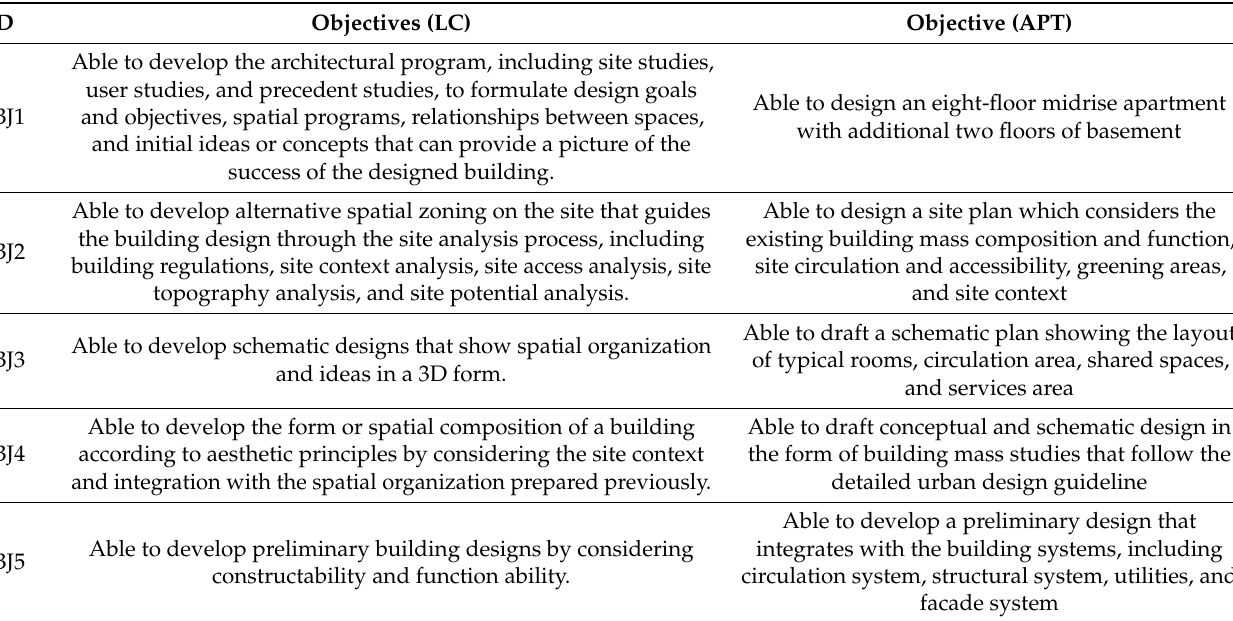
Figure 3. Site aerial view ( a ) and site plan ( b ) were used to form the design studio projects. (Image source, ( a ): Google Earth). Table 1. Studio objectives of LC and APT